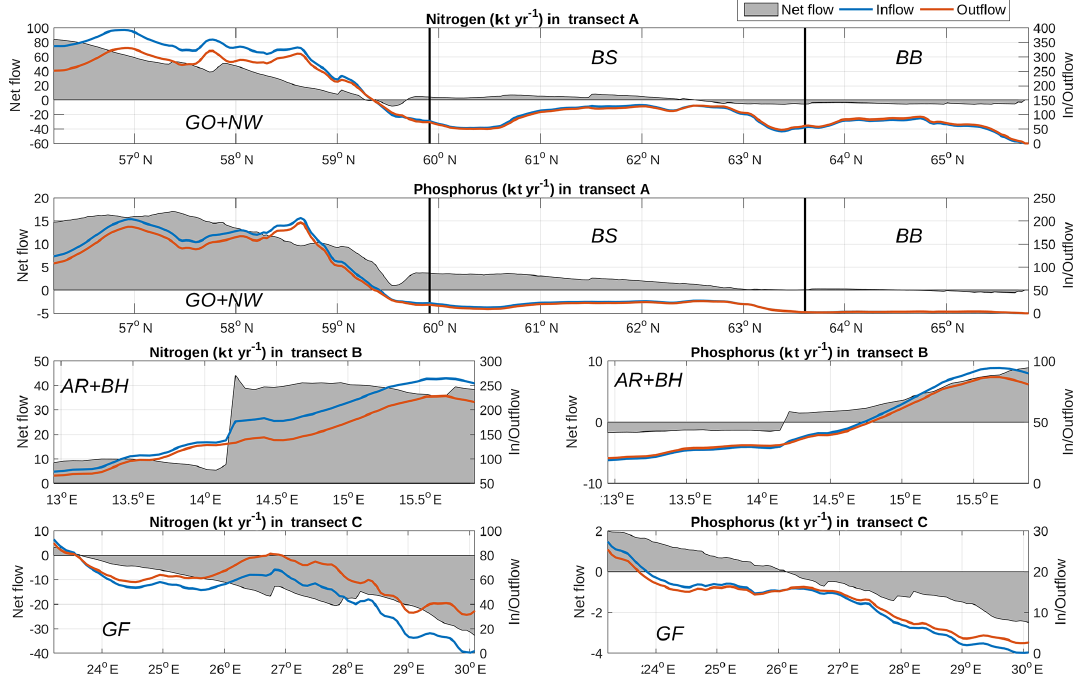
Figure 12. Annual mean fluxes of nitrogen (in ktyr − 1 ) and phosphorus (in ktyr − 1 ) as a function of the cross sections along transects following the latitude and longitude in the Baltic sub-basins. Northward and eastward fluxes are, by definition, positive and called inflows. Southward and westward flows are called outflows. Net flow is the difference between in- and outflows. Here, AR, BH, GO, NW, GF, BS and BB represent the Arkona Sea, Bornholm Sea, eastern Gotland Basin, northwestern Gotland Basin, Gulf of Finland, Bothnian Sea and Bothnian Bay, respectively. Transect A summarizes fluxes from the southern Baltic proper to the Bothnian Bay. Transect B describes the Baltic Sea entrance area from the Arkona Basin to the Bornholm Basin and transect C summarizes fluxes in the Gulf of Finland (see Fig.